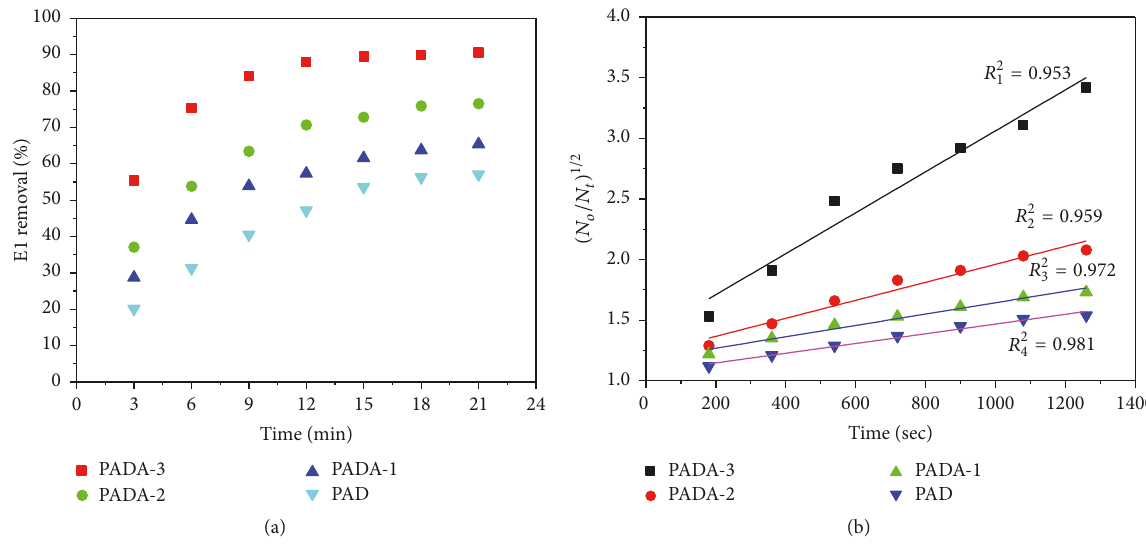
Figure 9: The variation of E1 removal (a) and (b) (𝑁 0 /𝑁 𝑡 ) 1/2 as a function of setting time for different flocculants.